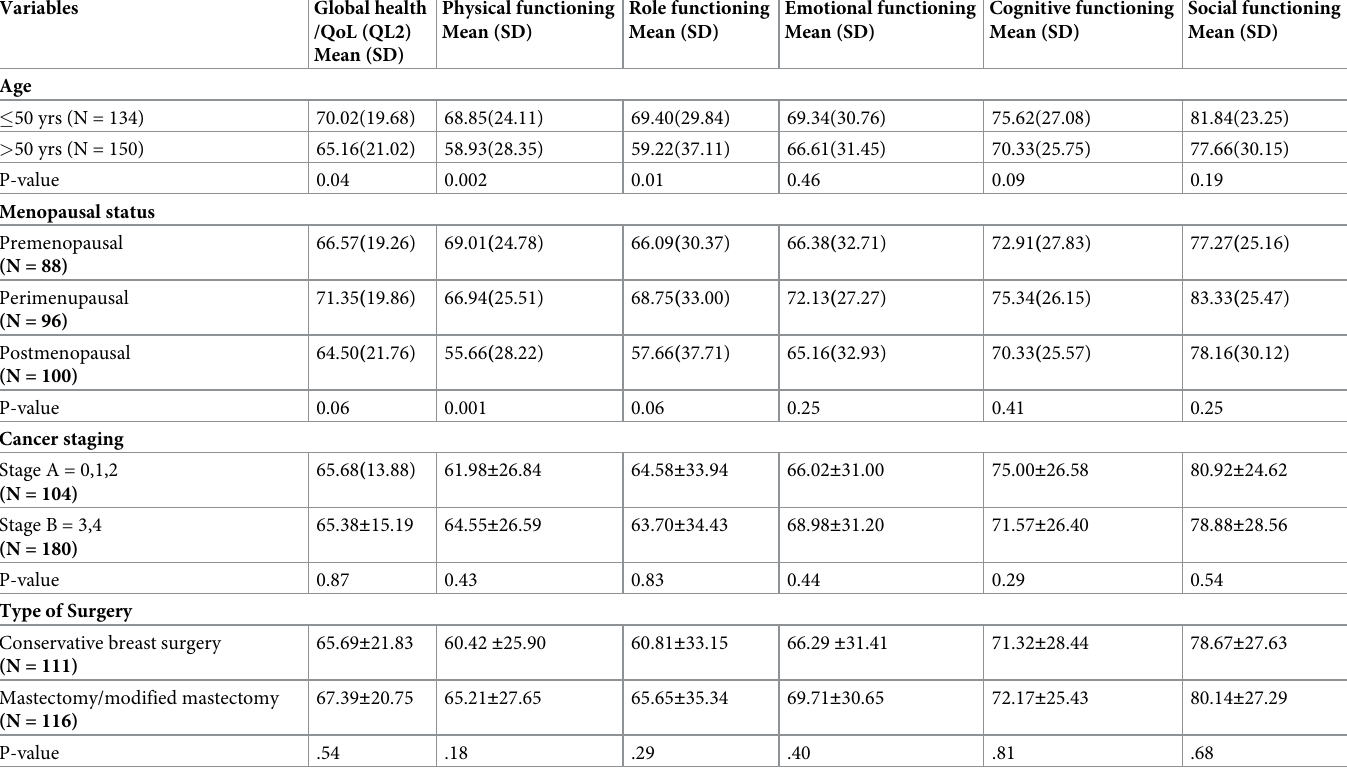
Table 3. Comparison of variables in global health and functional scales in QLQ-C30 (N =